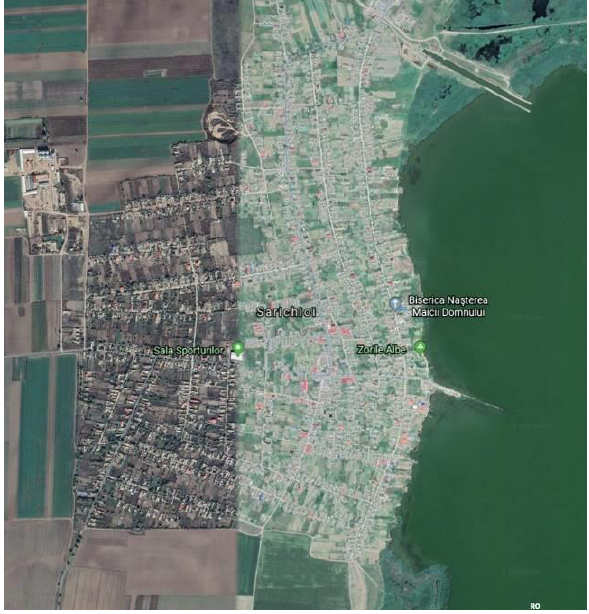
Figure 4. Sarichioi village seen from Google Earth. On the right hand side is the Razim lake.